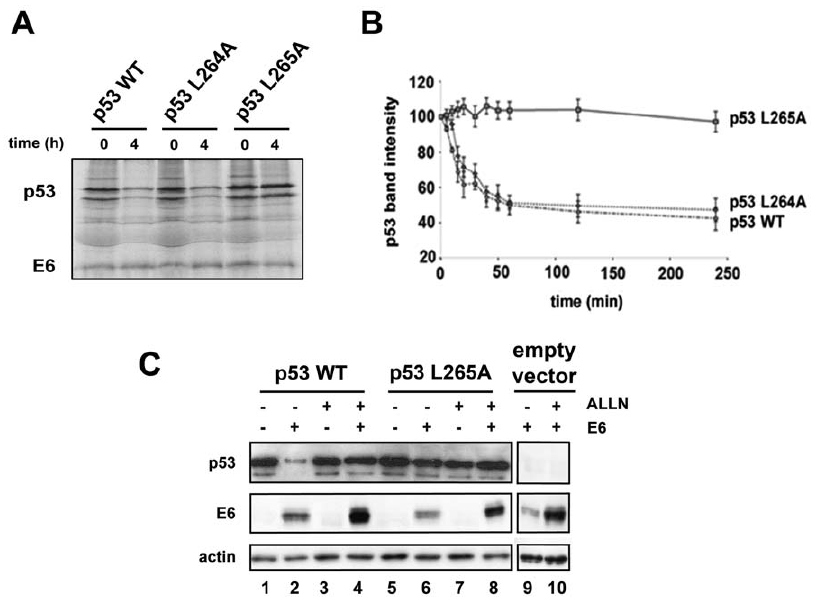
Figure 2. Degradation of p53 wild type and indicated mutants via E6. (A) Radiolabeled p53 (wild type and indicated mutants) and HPV16 E6 proteins produced in rabbit reticulocyte lysates were incubated together at 28 u C. Aliquots were removed at the indicated times before separation by 12% SDS-PAGE and exposition to photographic film. (B) Same experiment as in A, but levels of radiolabeled p53, after exposition to photographic film, were quantified by densitometry (BIO-RAD, Quantity One Software). Mean values (AU) 6 standard deviation for three independent experiments are shown. (C) H1299 cells were co-transfected by vectors for transient expression of HPV16 E6 and p53 proteins. Where indicated, 4 h prior to harvesting, the medium was supplemented with the 26S proteasome inhibitor ALLN at a final concentration of 100 m M. 24 h after transfection, extracted proteins were separated by 12% SDS-PAGE and analysed by Western-blotting using monoclonal anti-p53 antibody, polyclonal anti-actin antibody and monoclonal anti-16-E6 antibody.